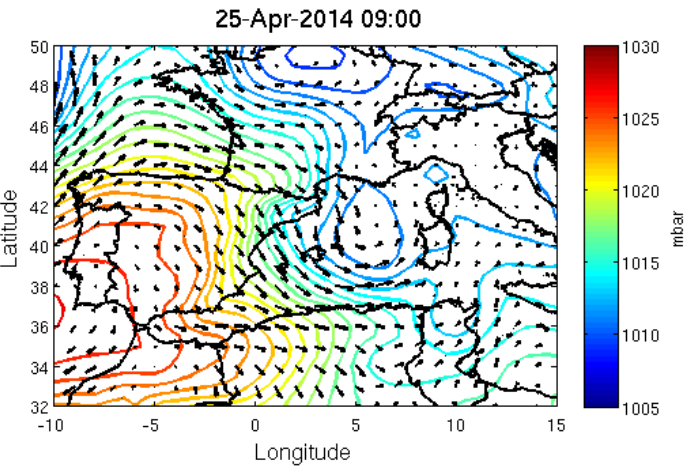
Figure 15. Synoptic situation on 25 April at 09:00 (i.e., during E3). This figure was created with data from the ECMWF reanalysis (http://www.ecmwf.int). The black arrows are the wind field at 10 m above the sea surface, and the contour plot corresponds to the sea level